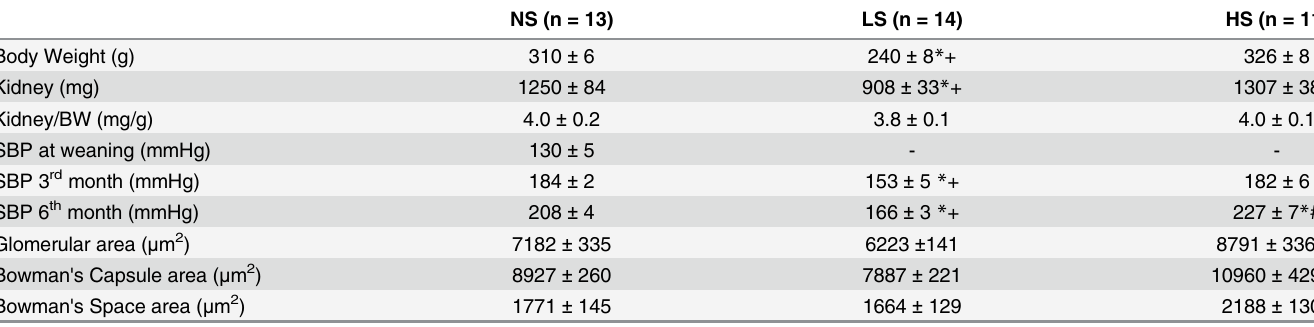
Table 1. Morphologic characteristics of the